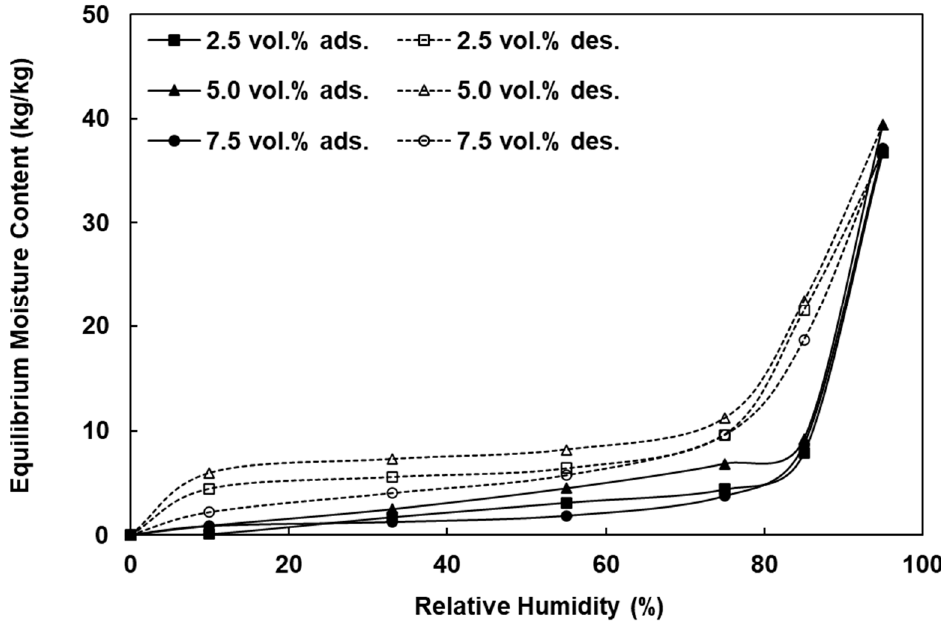
Figure 7. Equilibrium moisture content curve of grafted NH 2 -Al/MCM-41 with different amine functional groups.